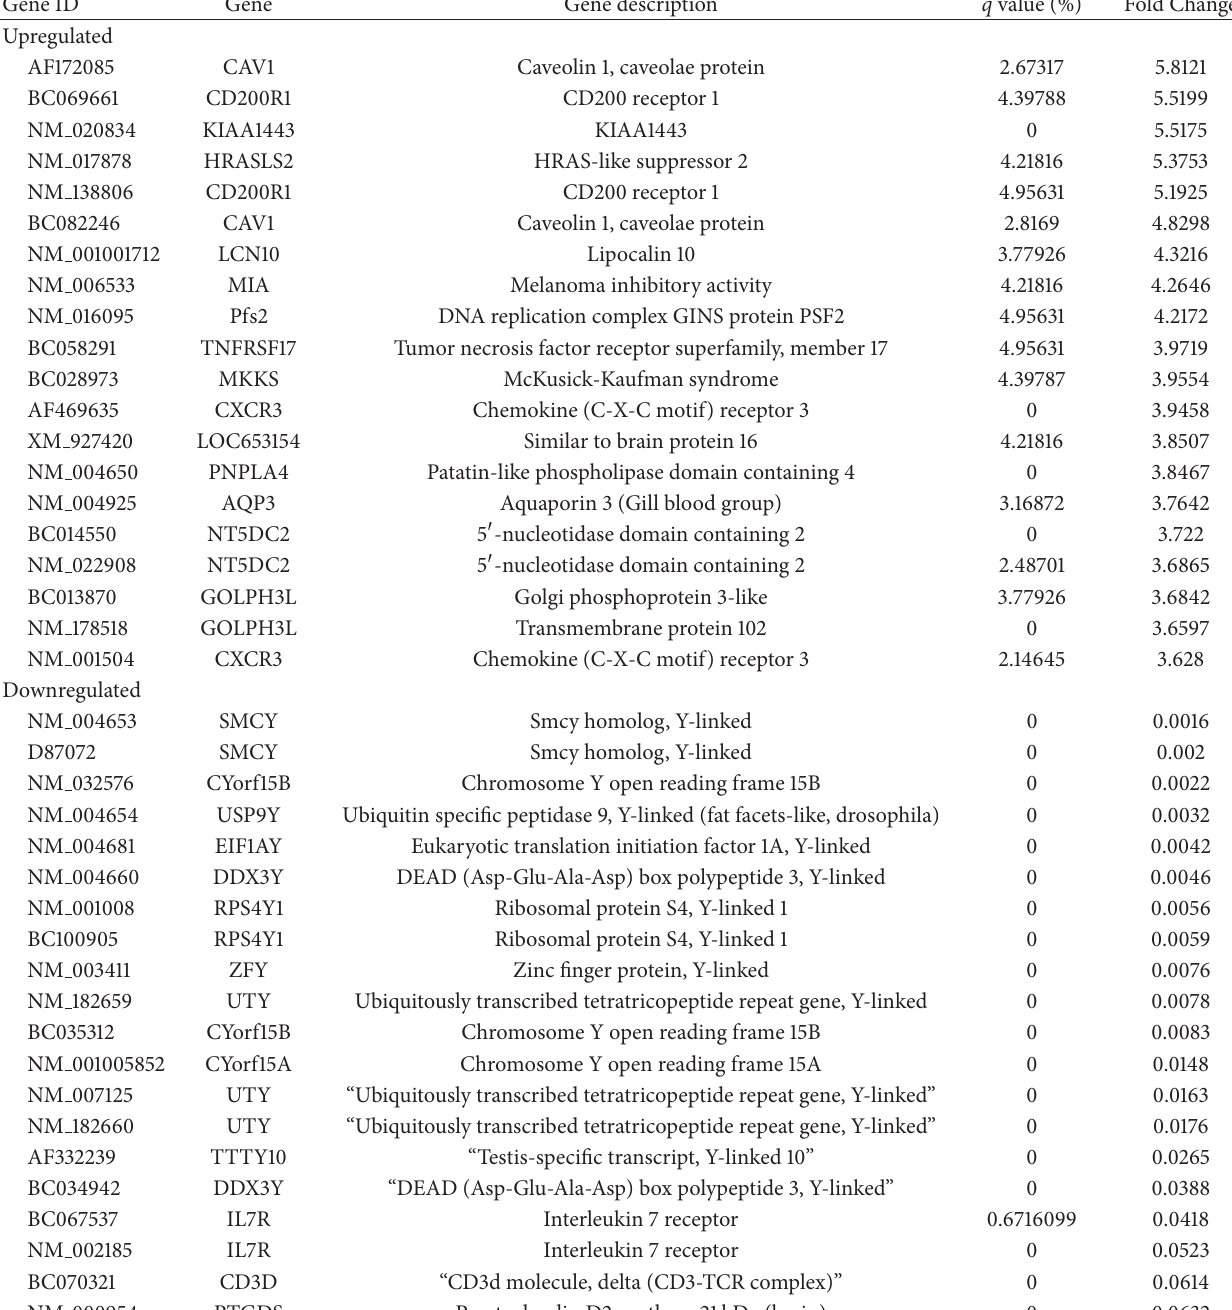
Table 2: The top 20 upregulated and downregulated differentially expressed genes between healthy females and males (fold change = ratio of healthy females/healthy